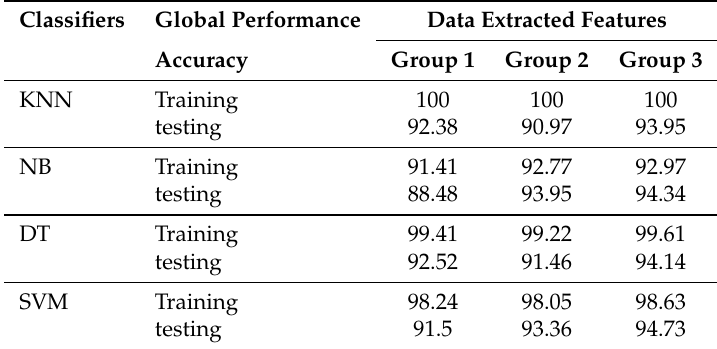
Table 4. Accuracies of extracted features based MSPCA with different classifiers.